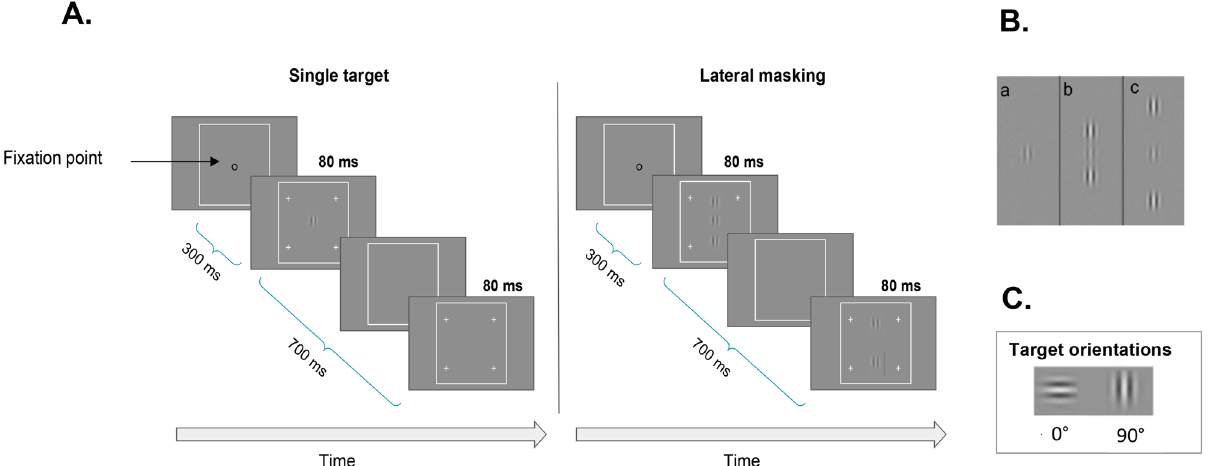
Figure 1. ( A ). Lateral masking paradigm. Participants must decide in which interval (the first or second) the central Gabor target has been presented. The contrast threshold of the target is measured using an adaptive method to reach the 79% correct threshold. ( B) . Examples of some target-to-flanker distances. (a) Single target, (b) at 3λ, (c) at 6λ. The contrast of the target was enhanced for demonstration purposes. ( C ). Illustrations of the single-target